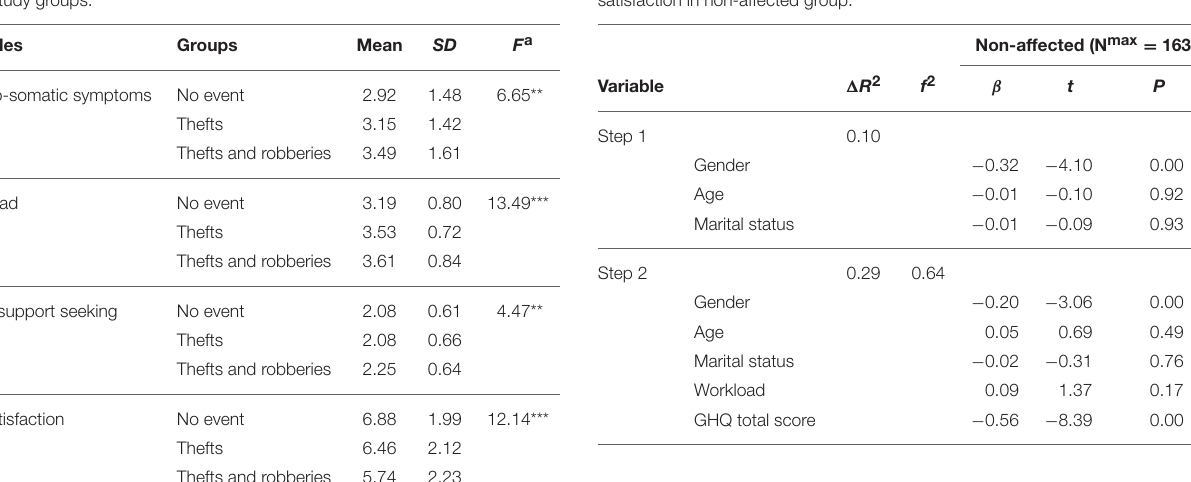
TABLE 4 | ANOVA results for workload and social support seeking among the three study groups.